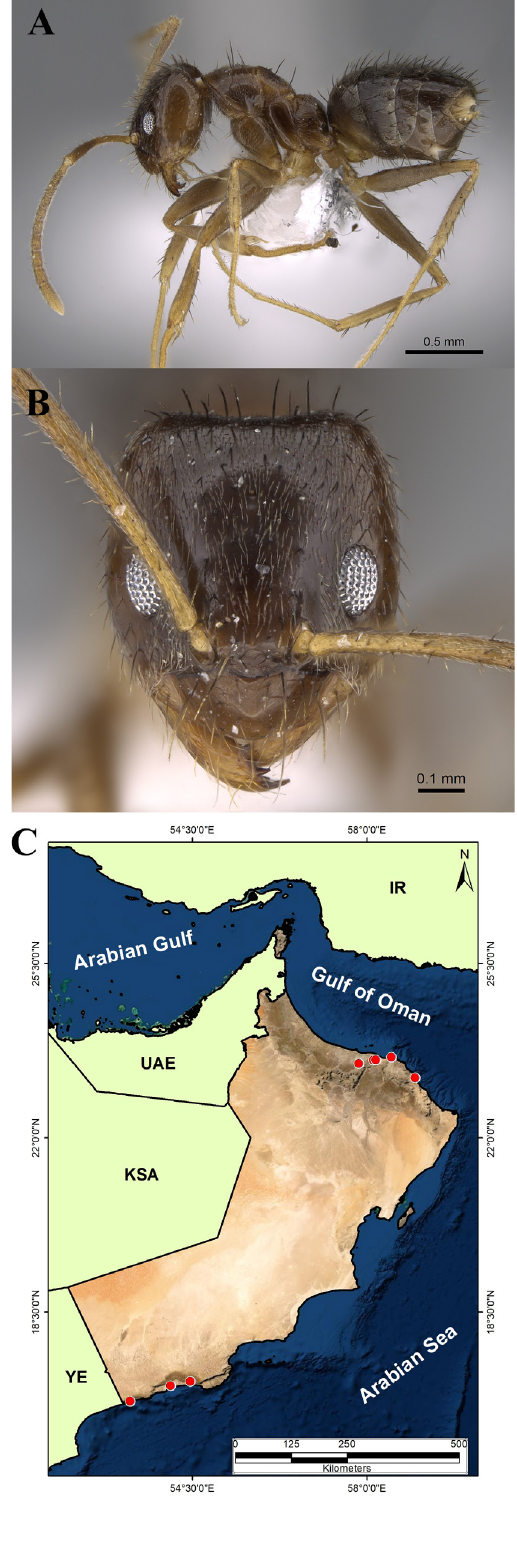
Fig. 22. Nylanderia jaegerskioeldi (Mayr, 1904), worker (CASENT0922881, AntWeb.org (Michele Esposito)). A . Body in profile. B . Head in full-face view. C . Distribution